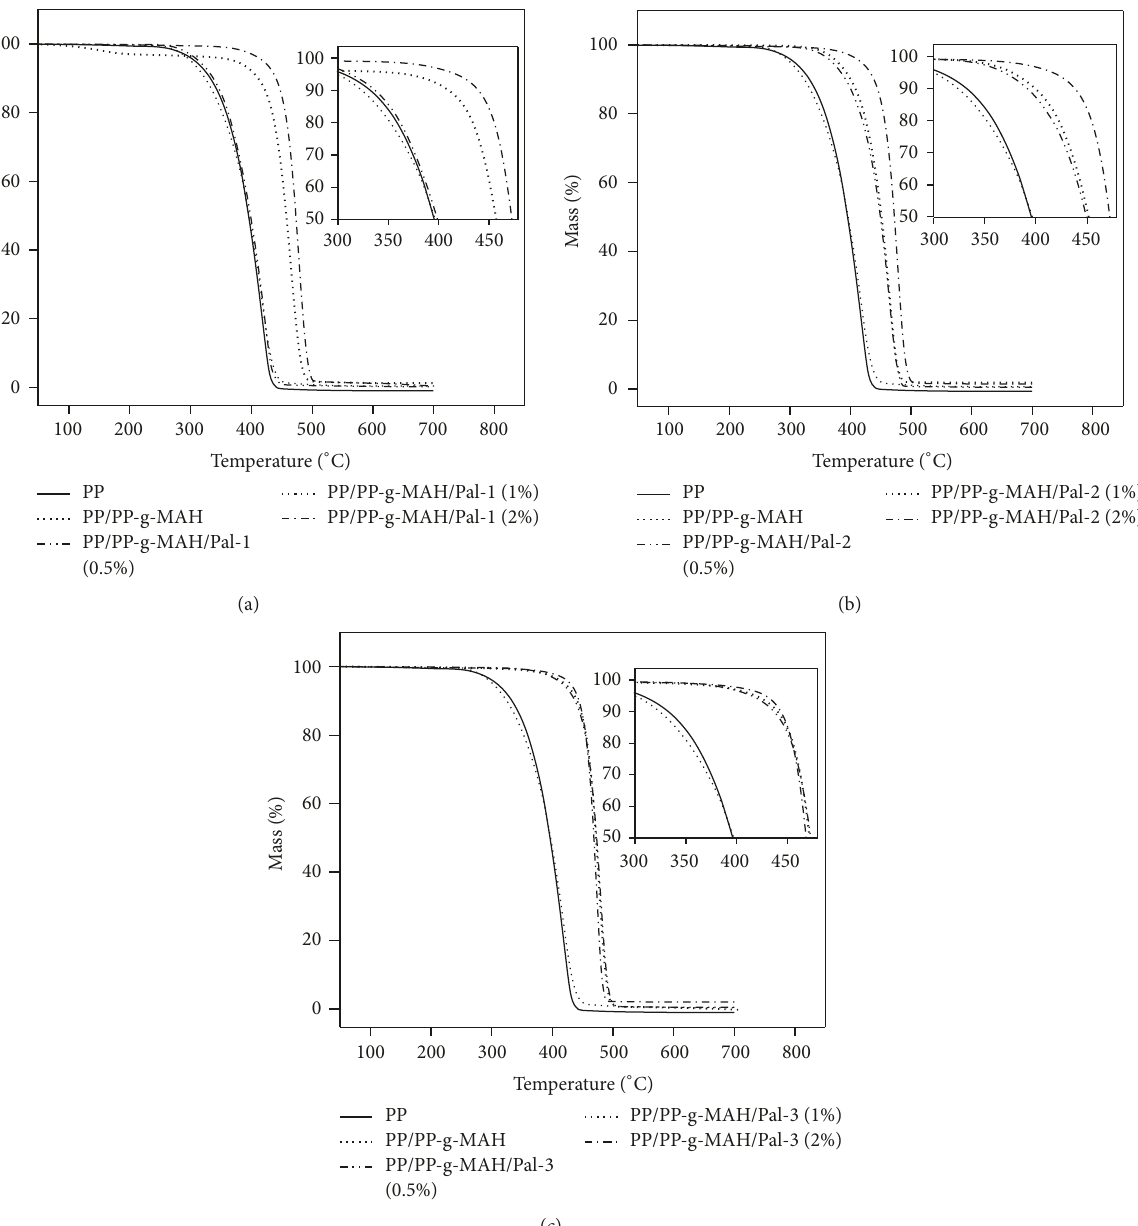
Figure 7: TGA traces for PP and PP/PP-g-MAH/Pal nanocomposites (0.5, 1, and 2 wt.% Pal content): (a) Pal-1, (b) Pal-2, and (c)